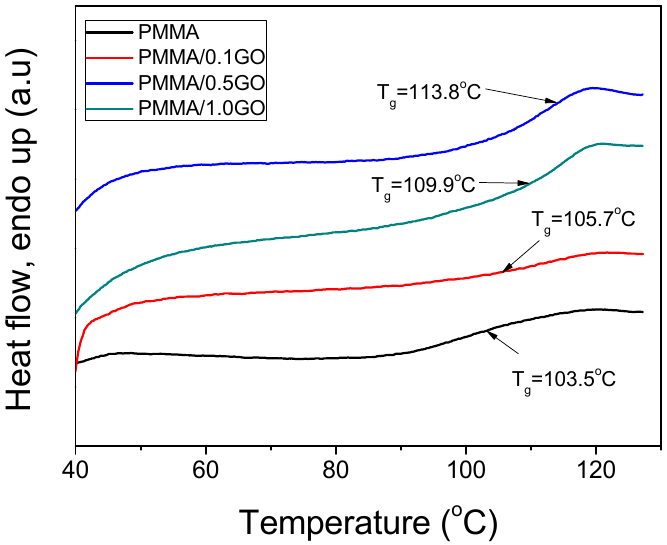
Figure 8. DSC traces of PMMA and all PMMA/GO nanocomposites, to estimate their glass transition temperatures.